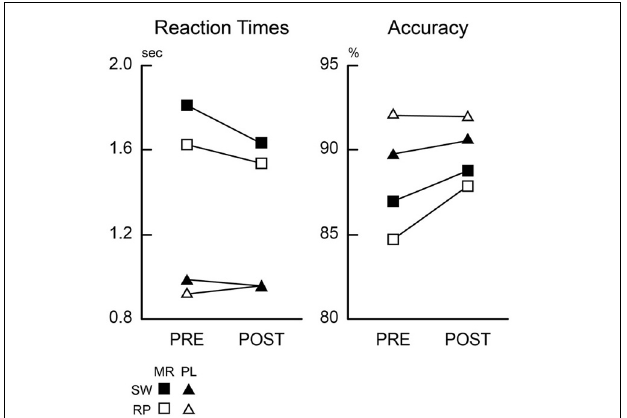
FIGURE 2 | Behavioral results. Mean reaction times and accuracy across participants are plotted for pre-training (PRE) and post-training (POST) sessions. Black-filled squares and triangles indicate mirror switch (MR/SW) and plain switch (PL/SW) trials, respectively. Open squares and triangles indicate mirror repeat (MR/RP) and plain repeat (PL/RP), respectively.